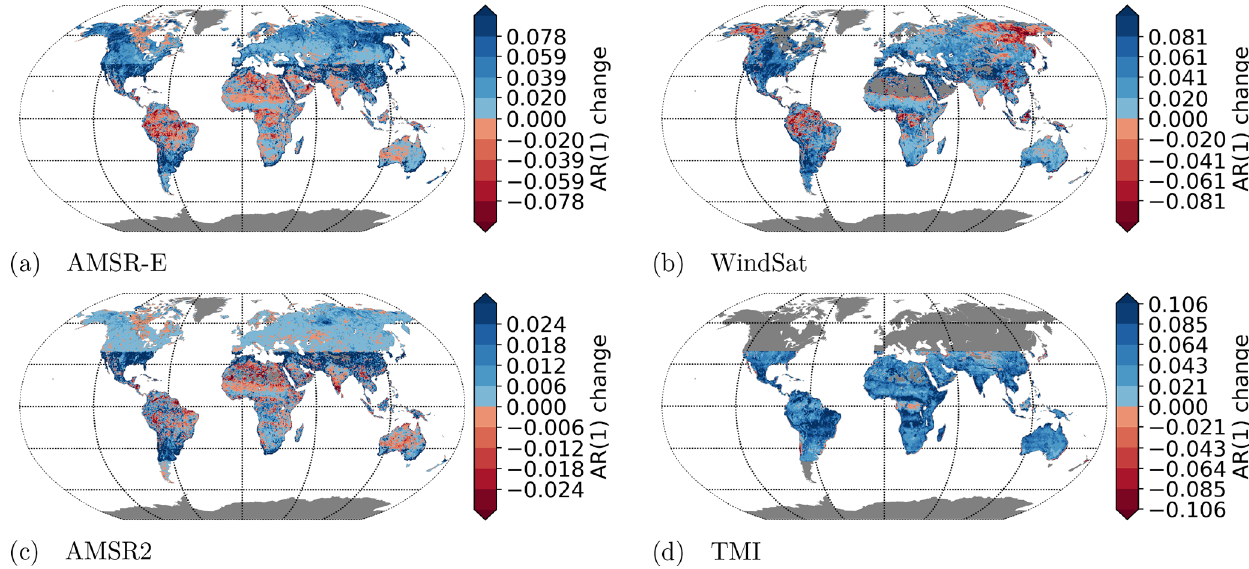
Figure 10. First-order autocorrelation change due to merging of X-band data for each sensor.